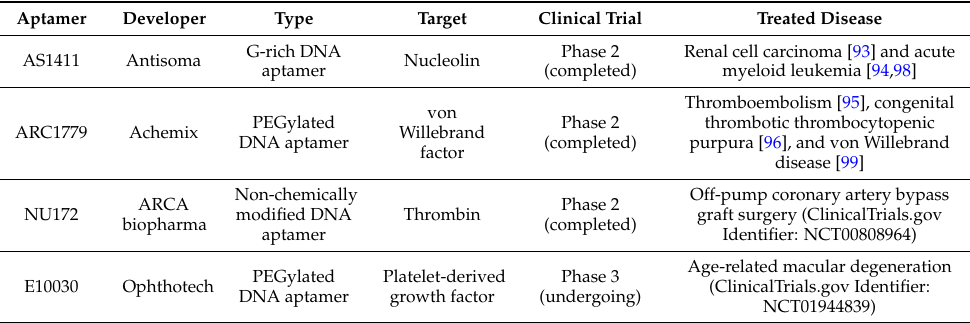
Table 2. DNA aptamers in clinical